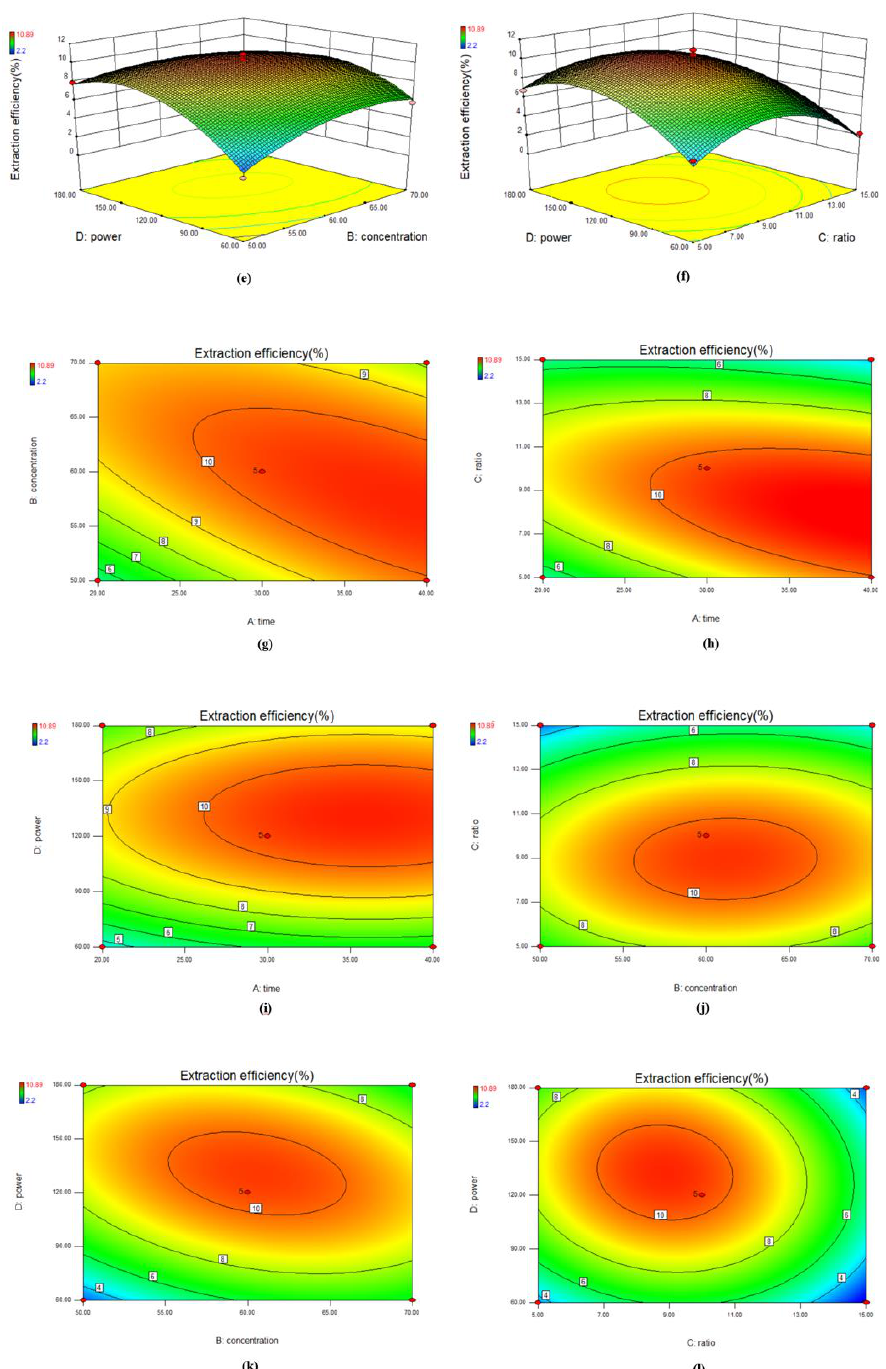
Figure 8. Three-dimensional response surface and 2D contour-lines map plots for the extraction efficiency of flavonoids: ( a , g ) Extraction time – Ethanol concentration; ( b , h ) Extraction time – Material liquid ratio; ( c , i ) Extraction time – Extraction liquid ratio; ( c , i ) Extraction time–Extraction power; ( d , j ) Ethanol concentration–Material liquid ratio; power; ( d , j ) Ethanol concentration – Material liquid ratio; ( e , k ) Ethanol concentration-Extraction power; ( f , l ) Material liquid ( e , k ) Ethanol concentration-Extraction power; ( f , l ) Material liquid ratio–Extraction ratio – Extraction power.